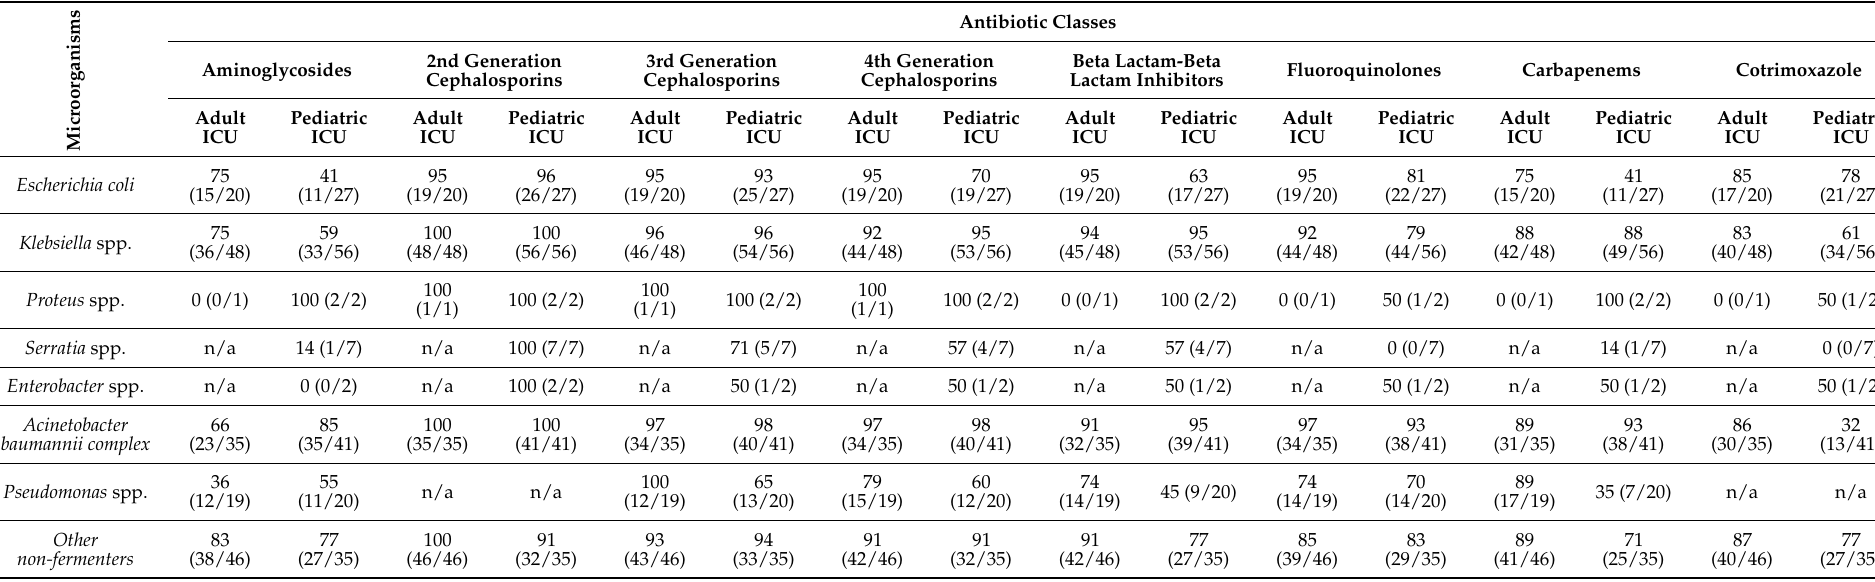
Table 3. Percentage (%) of antibiotic resistance among different Gram-negative bacterial isolates from both adult and pediatric ICUs.